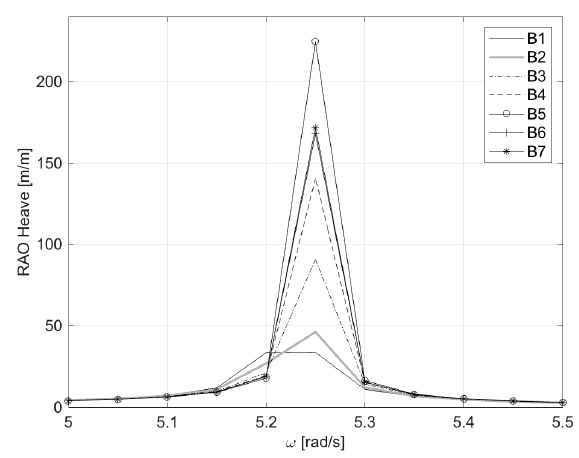
Figure A2. Comparison of heave RAO for sensitivity analysis.